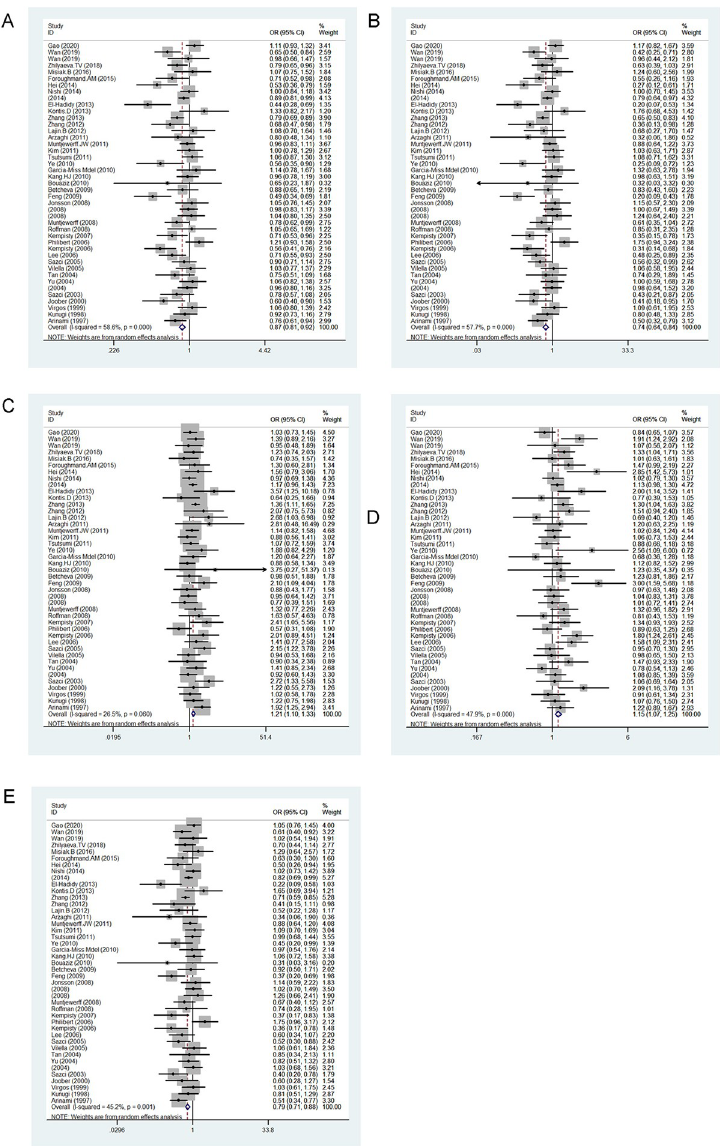
Fig 6. Forest plot of the association between 667C > T variation and risk of schizophrenia in the five genetic models: A, allele contrast; B, homozygous codominant; C, heterozygous codominant; D, dominant; and E, recessive.